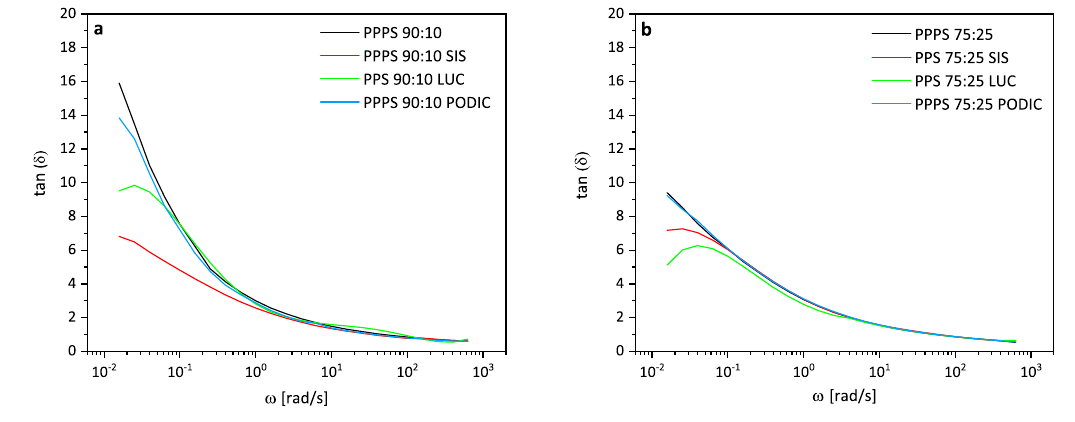
Figure 6. Loss factor of PP–PS 90:10 ( a ) and PP–PS 75:25 ( b ) blends; measured at 230 ◦ C.